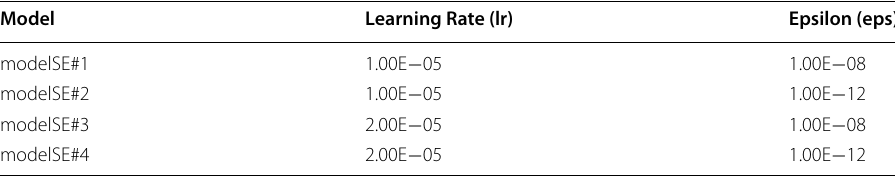
SE stacking ensemble